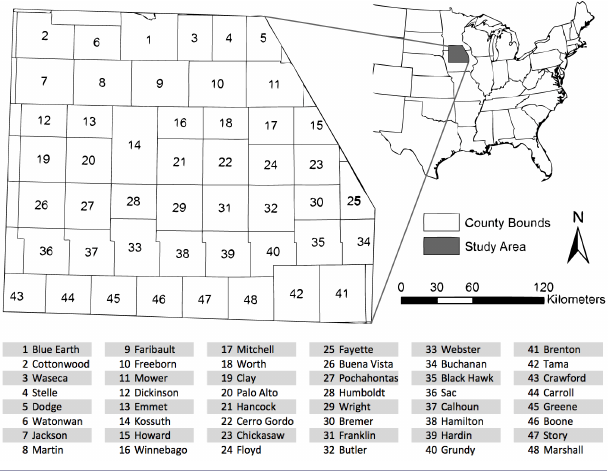
Fig. 1 . Map of study site, located the north central region of the United States. Data were aggregated at the county and study area levels. County data explicitly discussed are